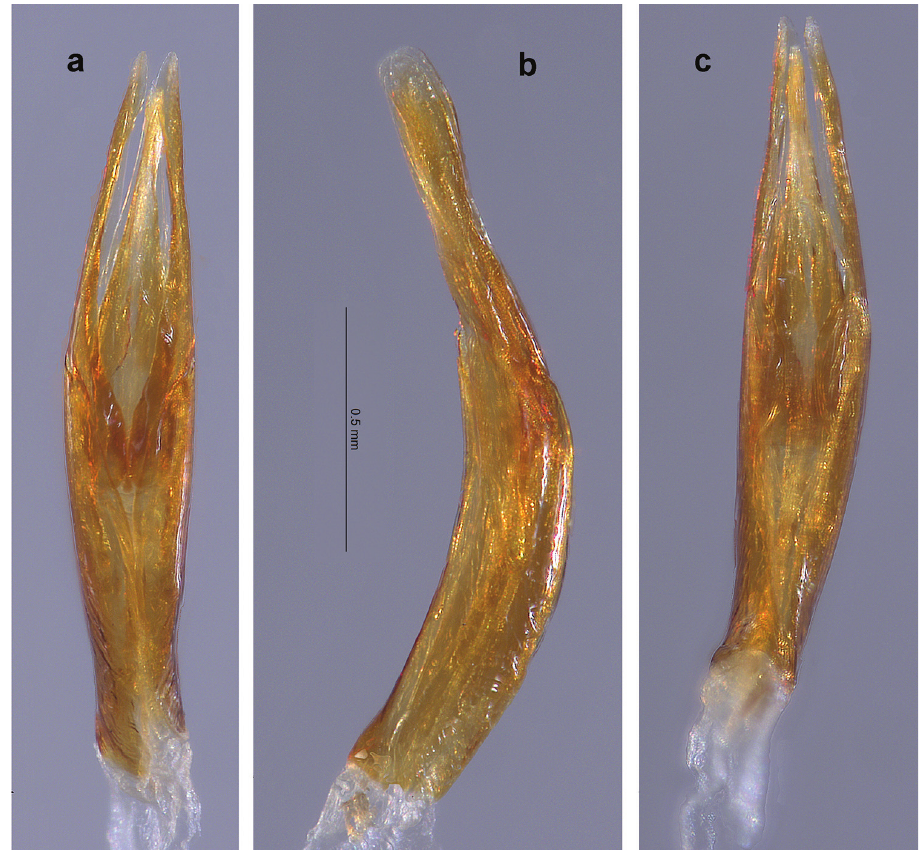
Figure 10. Amazonopsis camachoi sp. n., male genitalia of holotype a Dorsal view b Lateral view c Ventral